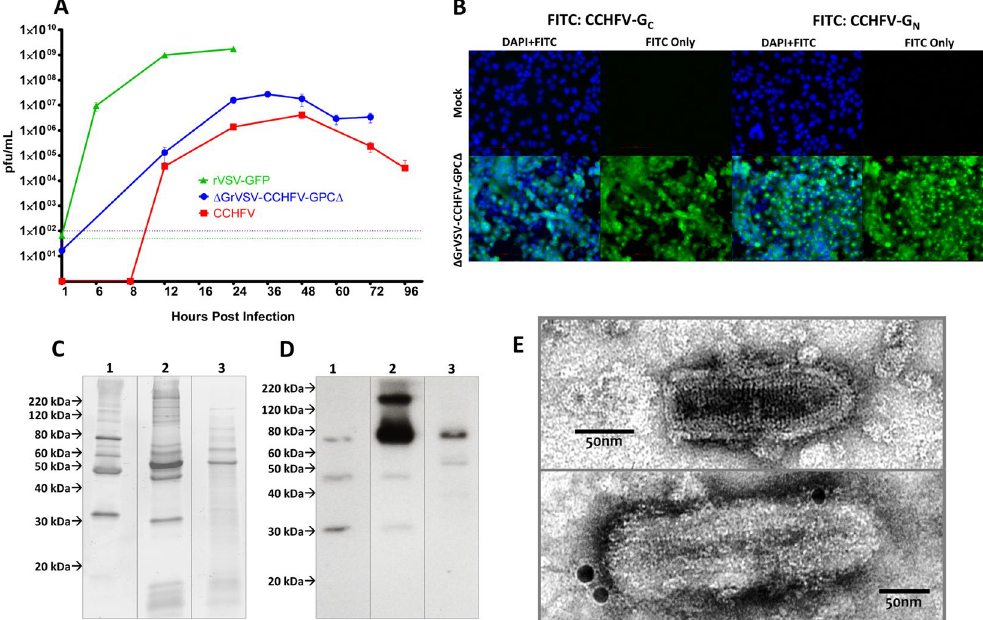
Figure 2. Characterization of rVSV vectors. ( A ) Single-cycle growth kinetics comparing recombinant vesicular stomatitis virus (rVSV) wild-type (Isolate: Indiana) tagged with green-fluorescent protein (GFP) (rVSV- GFP), the replication competent pseudotype ( Δ GrVSV-CCHFV-GPC Δ ), and Crimean-Congo hemorrhagic fever virus (CCHFV) (Isolate: IbAr10200) all at a multiplicity of infection (MOI 0.1) in baby hamster kidney (BHK) cells. Data shown are a mean ± standard deviation from three biological replicates, titrated by plaque assay in duplicate. ( B ) Fluorescence microscopy of Δ GrVSV-CCHFV-GPC Δ at MOI 0.01 infected human hepatocarcinoma (HuH-7) cells at 20x objective, with a nuclear stain of 4 ′ ,6-diamidino-2-phenylindole (DAPI) and GPC antigens stained with α -CCHFV-G c monoclonal antibody (MAb) 8A1 and α -CCHFV-PreG N MAb 13G8 using a Fluorescein isothiocyanate (FITC) conjugated secondary, fixed and permeabilized at 24 hpi, respectively. ( C ) Coomassie of approximately 100 ng of loaded 20% sucrose cushioned/semi-purified and gradient purified particles on 4–16% gradient Mini-PROTEAN TGX (Tris-glycine precast) gels. 1: rVSV-GFP, 2: Δ GrVSV-CCHFV-GPC Δ , and 3: CCHFV. Particle preps were stained with Coomassie Fluor Orange. ( D ) Western blot of approximately 100 ng of loaded 20% sucrose cushioned/semi-purified and iodixanol gradient purified particles on 4–16% gradient TGX gels. 1: rVSV-GFP, 2: Δ GrVSV-CCHFV-GPC Δ , and 3: CCHFV. Particle preparations were stained with α -CCHFV-G C MAb 11E7 using an HRP-conjugated secondary. ( E ) Transmission electron micrographs of rVSV-GFP and replication competent Δ GrVSV-CCHFV-GPC Δ particles from BHK cells, semi-purified using a 20% sucrose cushion or purified using iodixanol gradient centrifugation, negatively stained with 2% aqueous uranyl acetate, immunolabeled with α -CCHFV-G c MAb 11E7 and a secondary 15 nm gold labeled secondary. Samples were fixed with 2% glutaraldehyde. Images were adjusted for brightness, contrast, and formatted for size for display purposes. Coomassie gel and western blot images were cropped from the same image file at same imaging parameters for ease of viewing. Gel and blots originals are available in supplemental information. Other original raw data files available upon